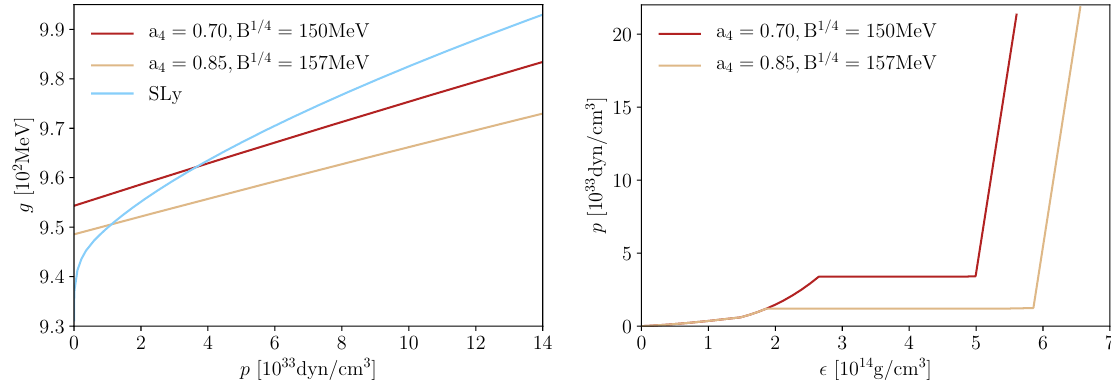
Figure 2. Left panel: Gibbs free energy g as function of pressure p . For the SQM EoS we set a 2 = 5000 MeV 2 . The point at which SLy and SQM curves intersect determines the transition pressure p T and the transition Gibbs free energy g T . For pressures greater than p T the SQM free energy becomes lower than the SLy free energy, thus being energetically favorable. Right panel: EoS for the HyS constructed by the junction of the SLy EoS and two parameter set for the SQM EoS. We assume a first order phase transition between hadronic and strange quark matter and we set a 2 = 5000 MeV 2